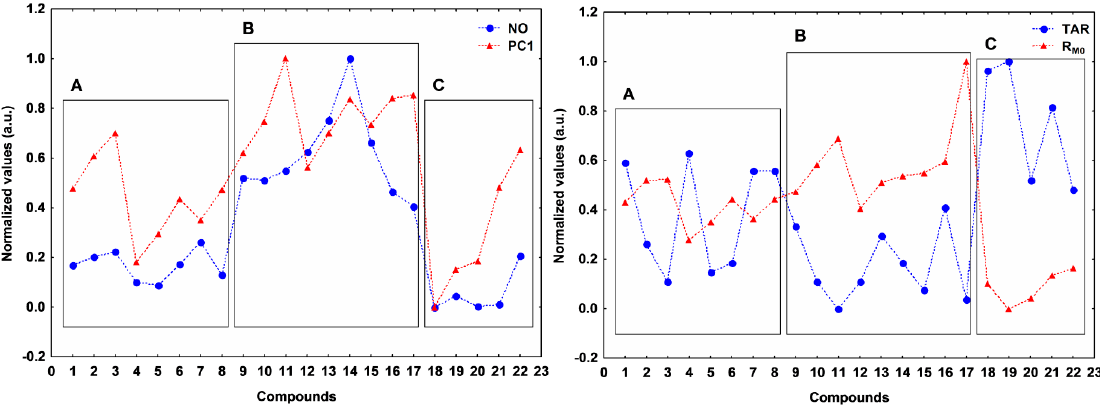
Figure 9. Profiles of NO vs. PC1 ( left panel ) and TAR vs. R M0 ( right panel ) for all studied compounds.